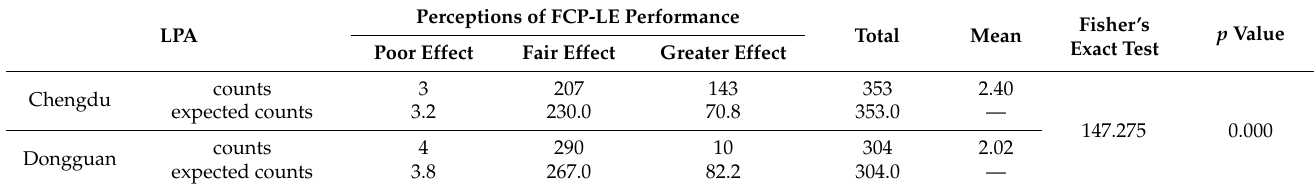
Table 8. Rural households’ overall perceptions of the performance of FCP-LE.